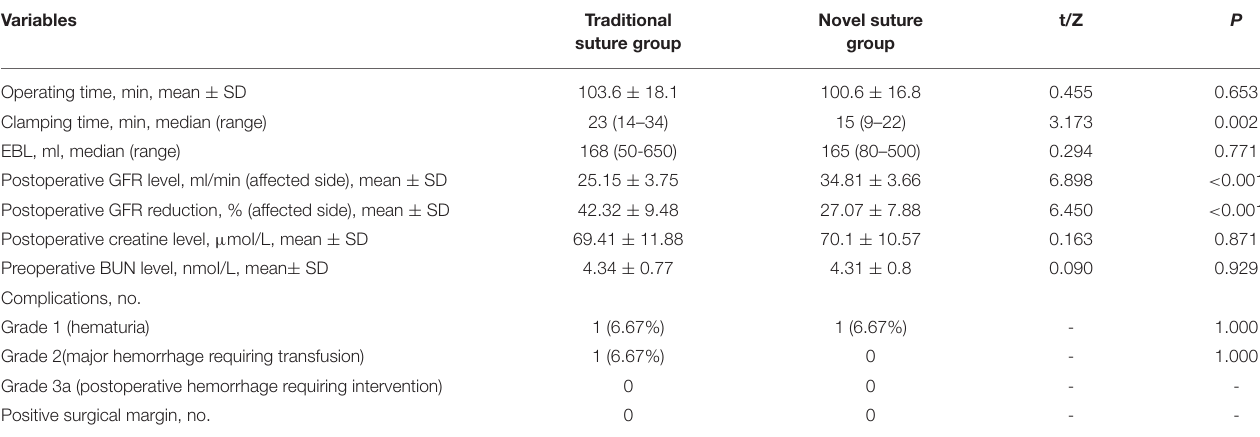
TABLE 2 | Surgical characteristics.